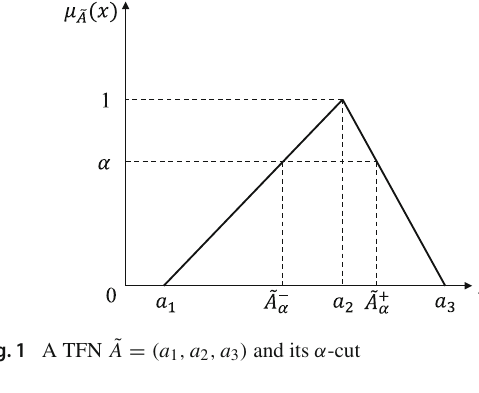
Fig. 1 A TFN ˜ A = ( a 1 , a 2 , a 3 ) and its α -cut